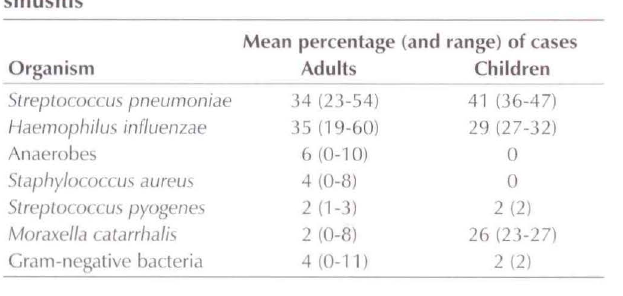
Microbial causes of community-acquired acute bacterial